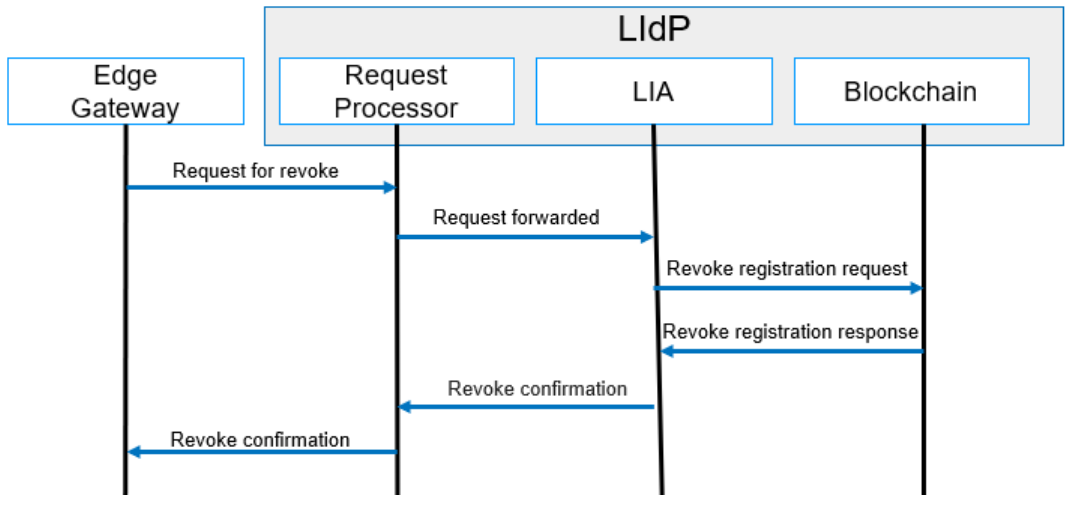
Figure 11. Revocation process message flow.